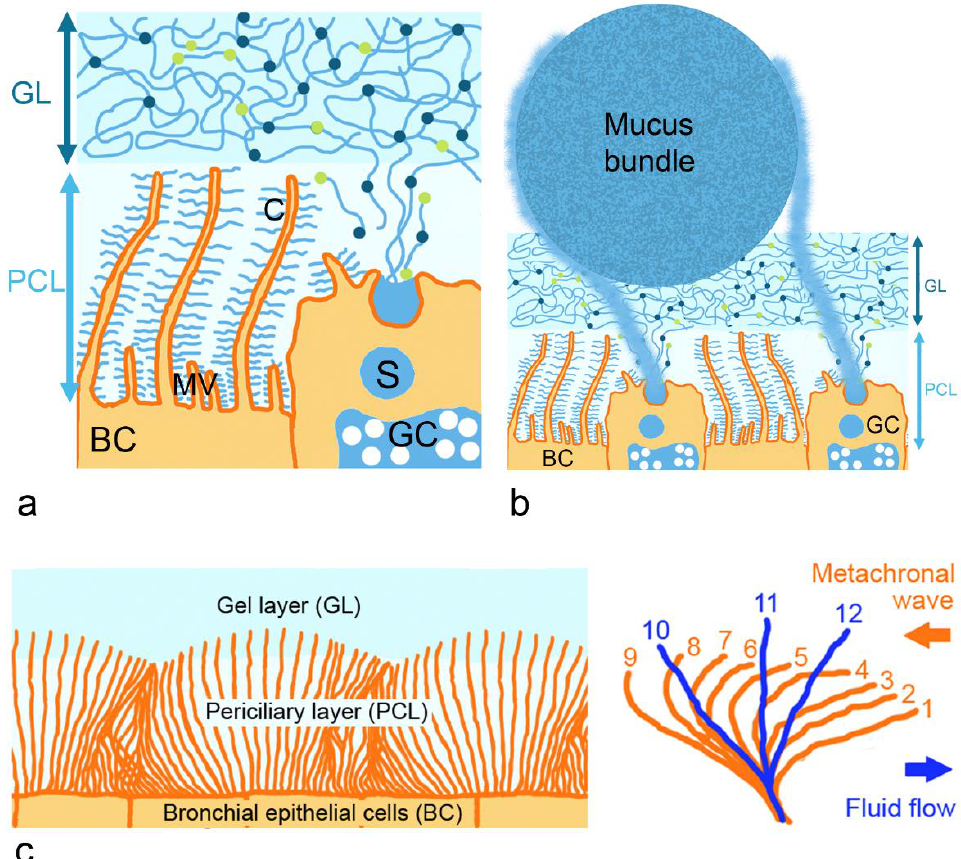
Figure 2. Respiratory mucus is arranged in periciliary (PCL) and gel layer (GL, ( a )), where mucins form the structural basis of the mucus. Thick mucus bundles consisting of MUC5B and coated with MUC5AC nets, produced by the intraepithelial goblet cells (GC), are partly embedded in the GL ( b ). Mucus transport by ciliary beating relies on mucus gel layer and periciliary layer with correct viscosity and osmotic pressure ( c ). The tips of the cilia follow an elliptic trajectory during the beating. Abbreviations: BC, bronchial epithelial cells; C, cilia; MV, microvilli; S, secretory granule. Mucus consists of approximately 95% water, 0.2–5.0% mucins, 0.5% globular pro- teins, 0.5–1% salts and 1.2% lipids, DNA, cells and cellular debris. Important mucus fea- tures are the pH, pore size of the mesh, ionic strength and viscosity. Data for healthy and